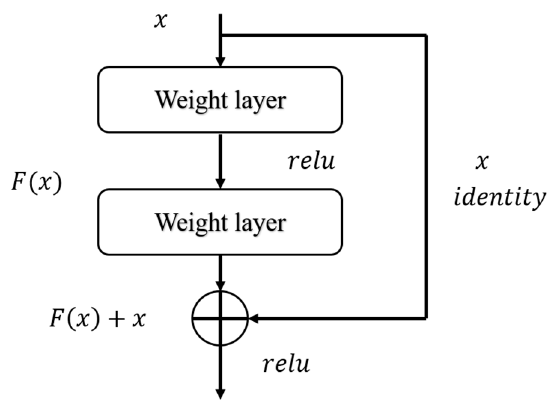
Figure 2. The building block of